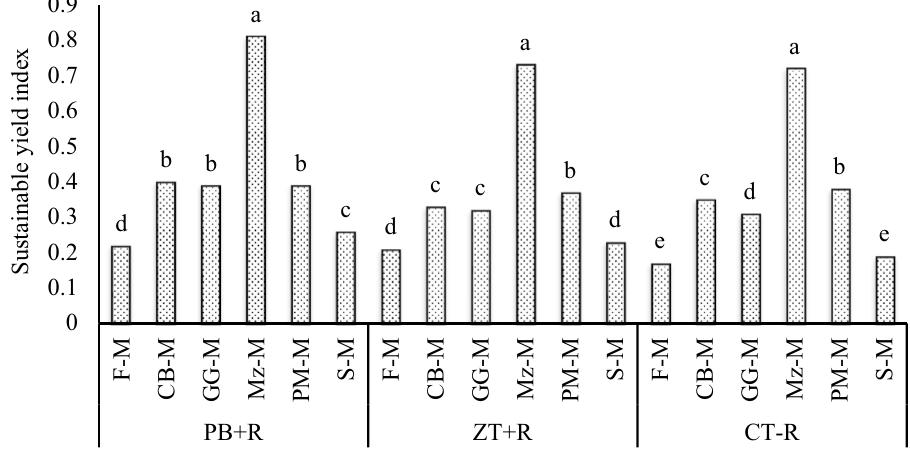
Figure 3. Sustainable yield index of different CA-based Indian mustard-based systems (3-year mean).